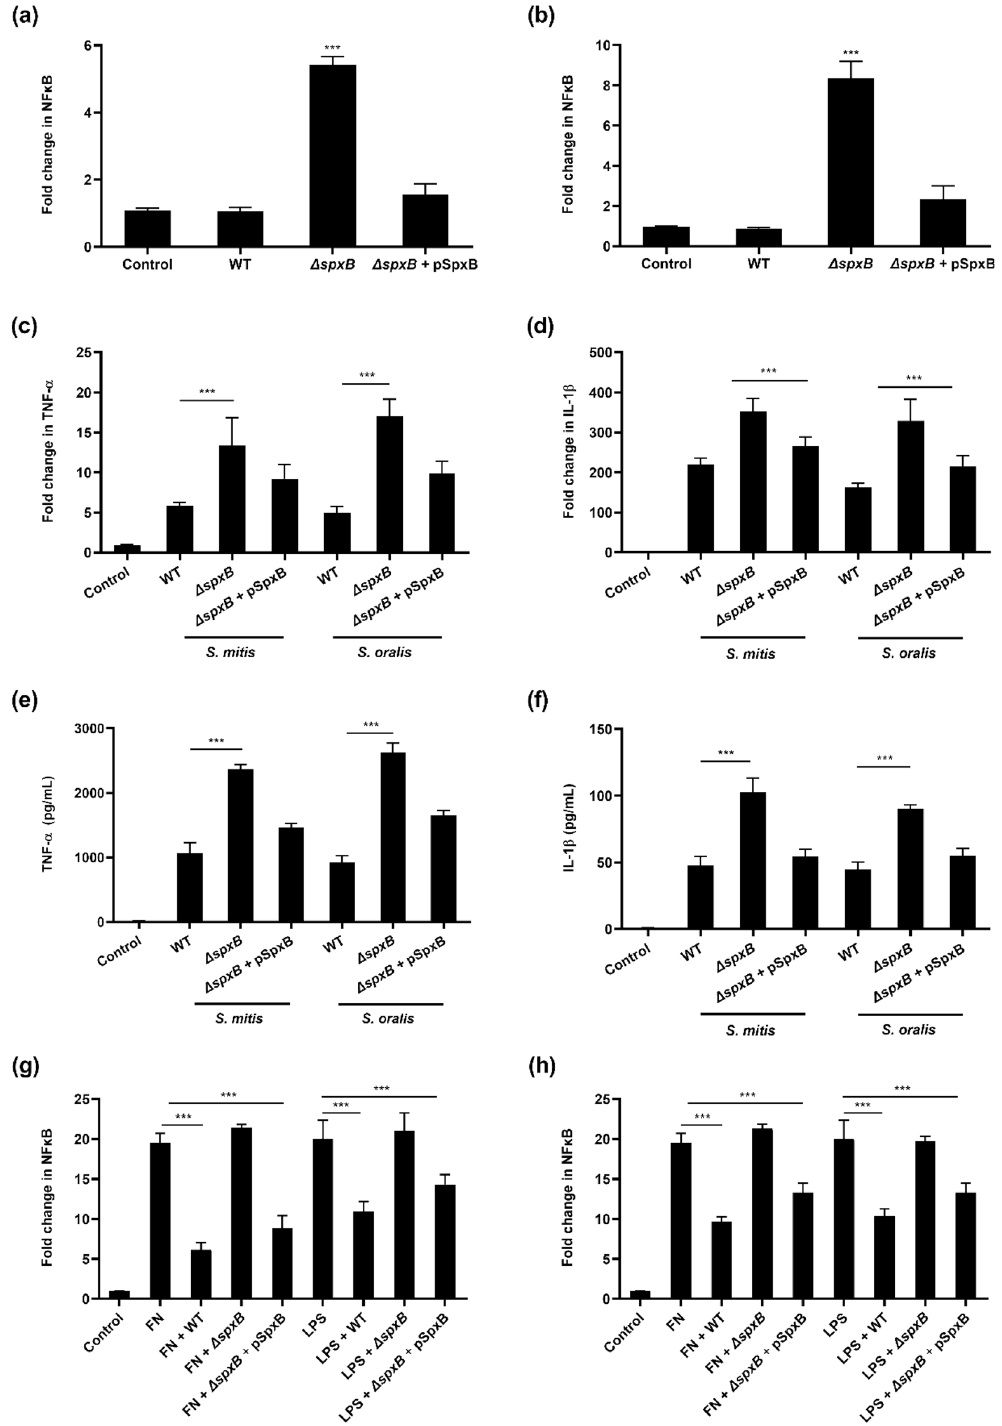
Figure 4. Bacterial pyruvate oxidase mediated suppression of the host NFĸB. Raw 264.7 cells stably transfected with the NFĸB SEAP reporter were infected with wild-type (WT) bacteria, ΔspxB mutants and ΔspxB complemented mutant ( ΔspxB + pSpxB) of ( a ) S. mitis or ( b ) S. oralis . Cellular NFĸB activity was quantified by SEAP reporter assay. ***p < 0.001 compared to the control group. The expression of ( c ) TNF-α and ( d ) IL-1β were determined by qRT-PCR. Amount of ( e ) TNF-α and ( f ) IL-1β protein was determined by ELISA. Macrophages were incubated with WT, ΔspxB mutants or ΔspxB complemented mutant of ( g ) S. mitis or ( h ) S. oralis, in the presence or absence of F. nucleatum (FN) and LPS. ***p < 0.001